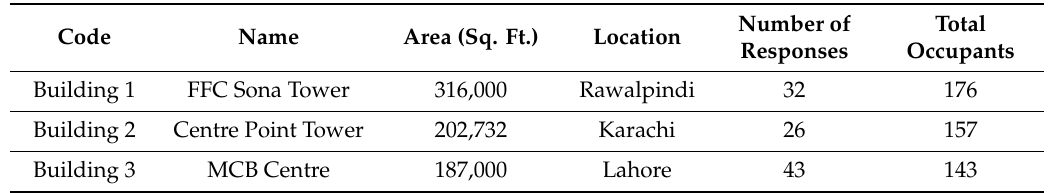
Table 2. Details of selected